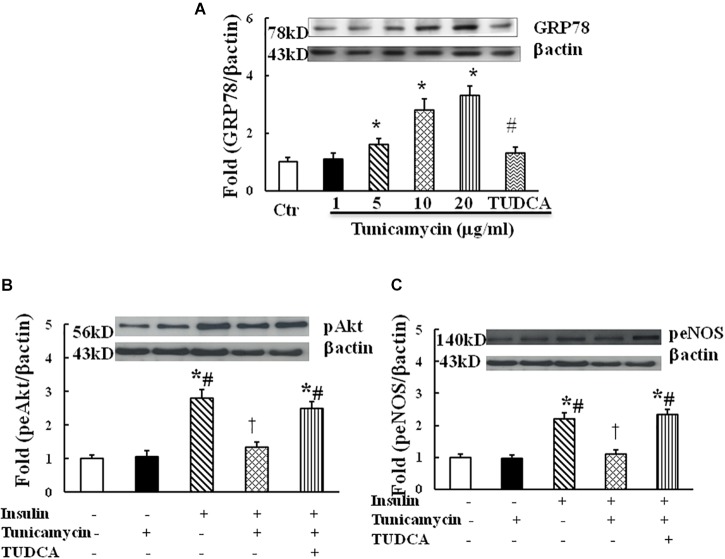
Effect of tunicamycin on the expression of GRP78 (A; N = 7 per condition), pAkt (Ser473, B; N = 7 per condition), peNOS (Ser1177, C; N = 7 per condition) in HUVECs. Tunicamycin (1–20 μg/mL) dose-dependently increased GRP78 expression, which was prevented by TUDCA (500 μg/mL) treatment. Tunicamycin (20 μg/mL) inhibited insulin-stimulated Akt and eNOS phosphorylation, TUDCA restored the expressions of pAkt and peNOS induced by tunicamycin. Data was presented as mean ± SE. Ctr, control; GRP78, glucose regulated protein 78. Loading control imagines for βactin were reused for pAkt and peNOS. ∗p < 0.05, vs. control group, #p < 0.05, vs. correspondence tunicamycin group, †p < 0.05 vs. insulin group.